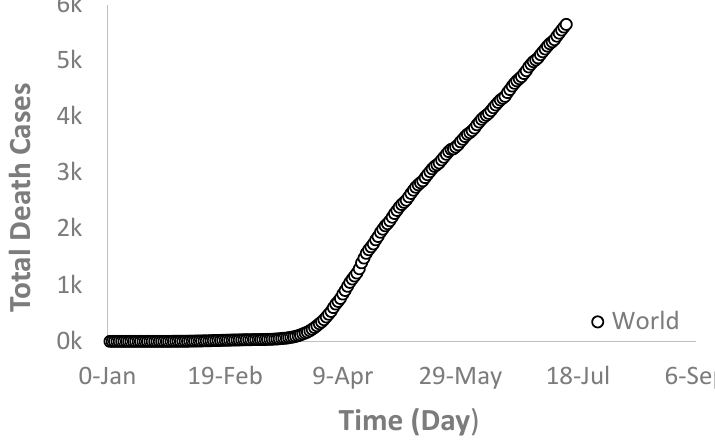
Figure 5. The world deaths due to the novel COVID-19 infections.